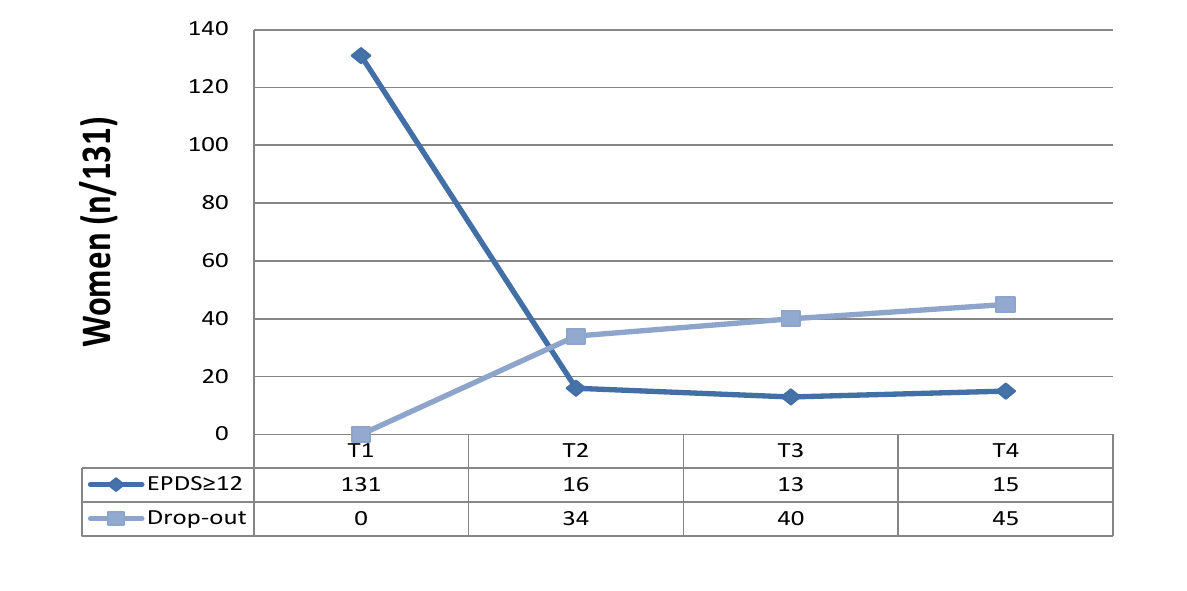
FIGURE1 Re-test and drop-out rates of women reporting EPDS total scores ≥ 12 at T1 (screening; N =